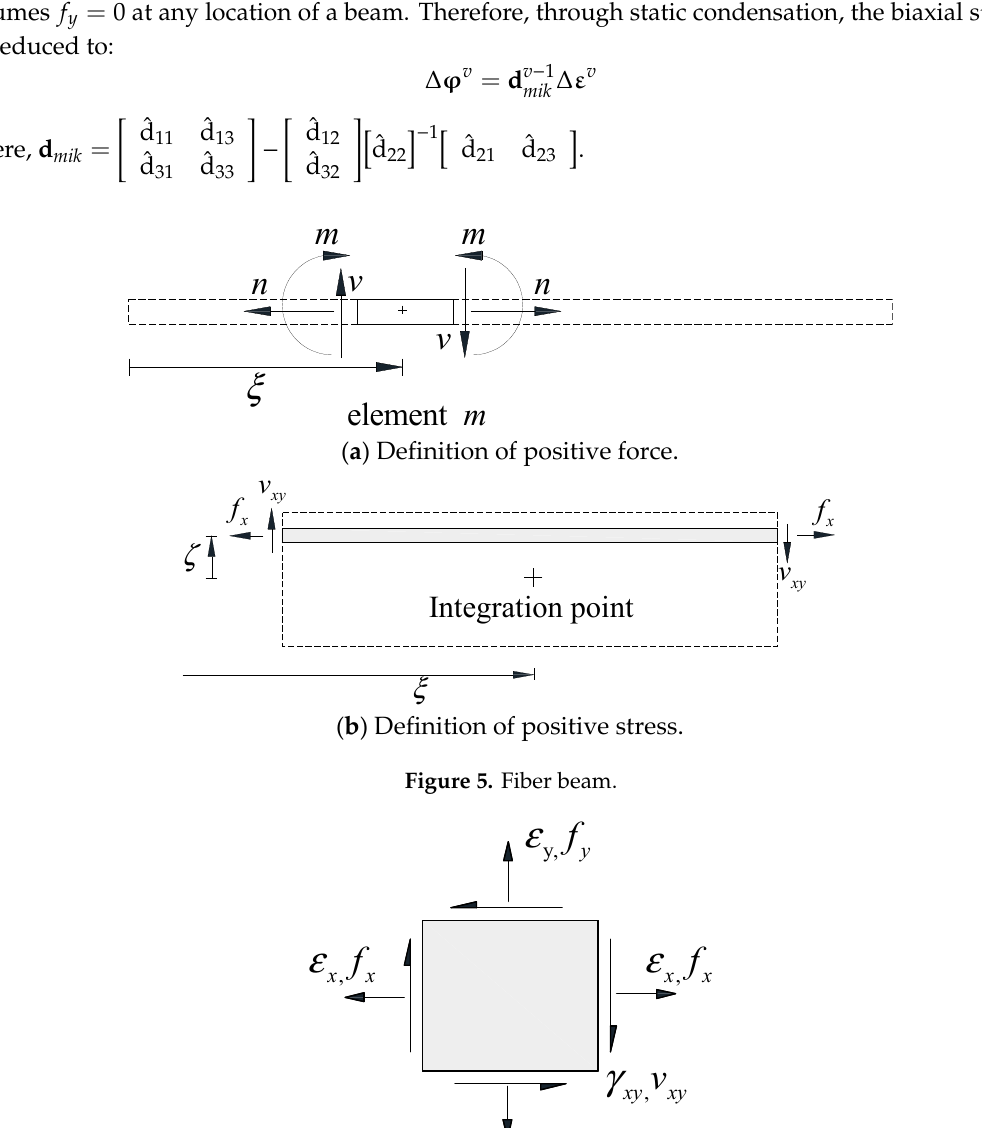
Figure 5. Fiber beam.